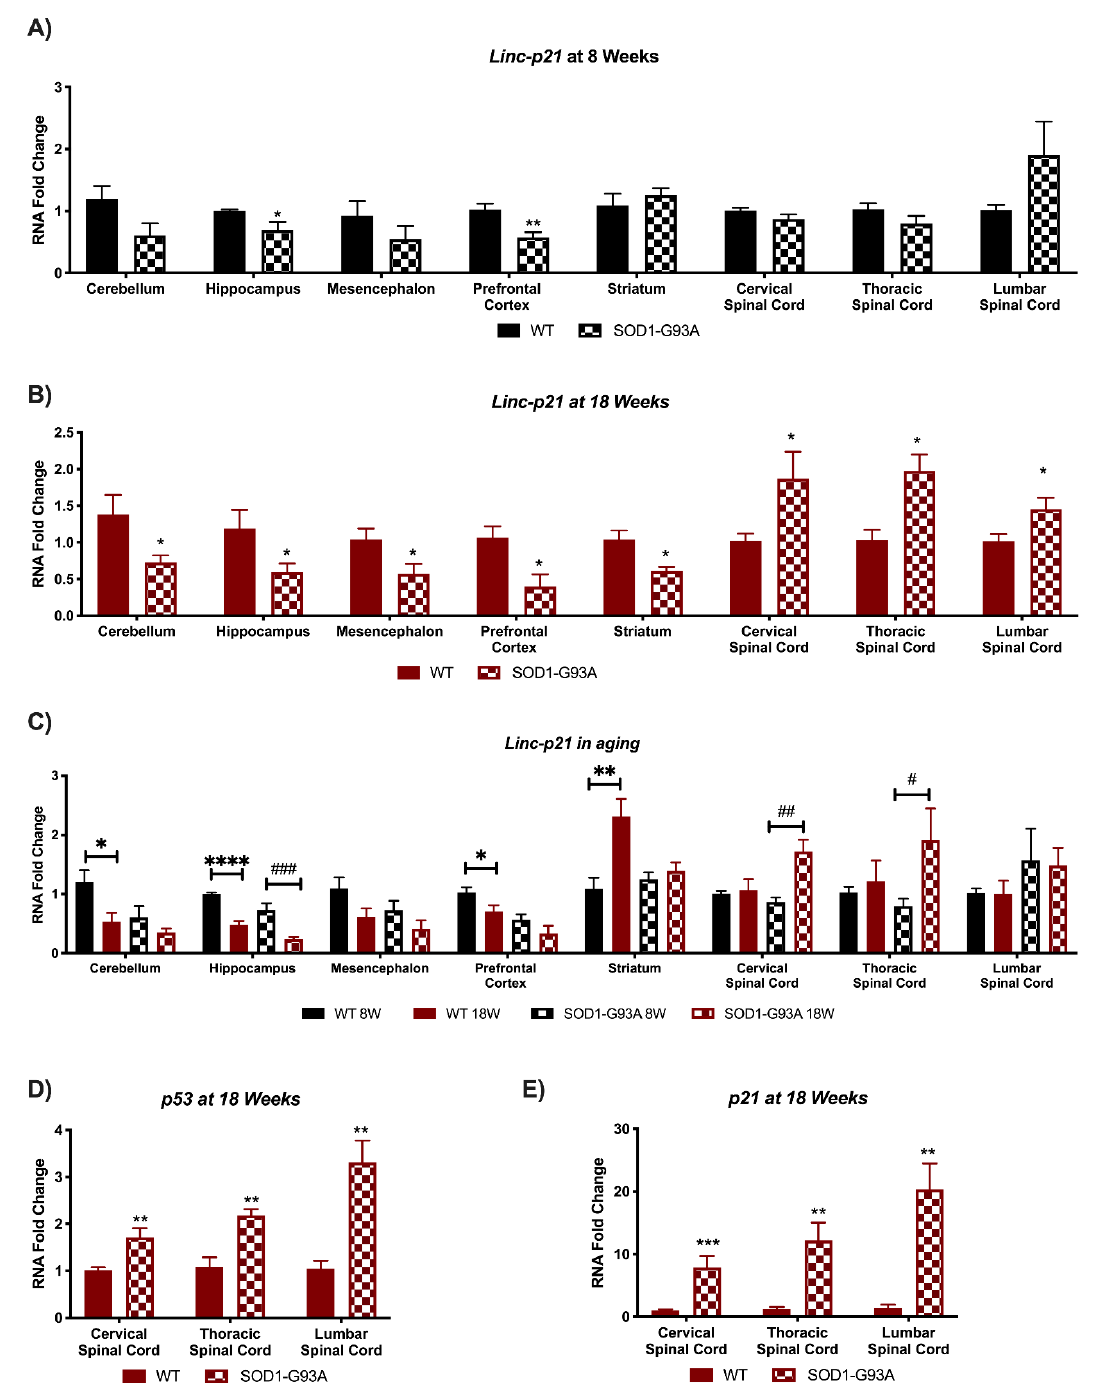
Figure 3. Linc-p21 is profoundly deregulated in SOD1-G93A mouse. RNAs expression levels were evaluated by Real Time-PCR in the different conditions. Data are expressed as mean ± SEM. ( A ) Linc-p21 expression in 8 weeks old WT ( n = 6) mice versus 8 weeks old SOD1-G93A mice ( n = 6). * p < 0.05, ** p < 0.01 vs. WT. ( B ) Linc-p21 expression in 18 weeks old WT ( n = 6) mice versus 18 weeks old SOD1-G93A mice ( n = 6). * p < 0.05 vs. WT. ( C ) Linc-p21 expression in 8 weeks old WT mice versus 18 weeks old WT ( n = 6) and 8 weeks old SOD1-G93A mice versus 18 weeks old SOD1-G93A mice ( n = 6). * p < 0.05, ** p < 0.01, **** p < 0.0001 vs. WT 8W, # p < 0.05, ## p < 0.01, ### p < 0.001 vs. SOD1-G93A 8W. ( D ) p53 expression in 18 weeks old WT ( n = 6) mice versus 8 weeks old SOD1-G93A mice ( n = 6) spinal cord areas. ** p < 0.01 vs. WT. ( E ) p21 expression in 18 weeks old WT ( n = 6) mice versus 18 weeks old SOD1-G93A mice ( n = 6) spinal cord areas. ** p < 0.01, *** p < 0.001 vs.